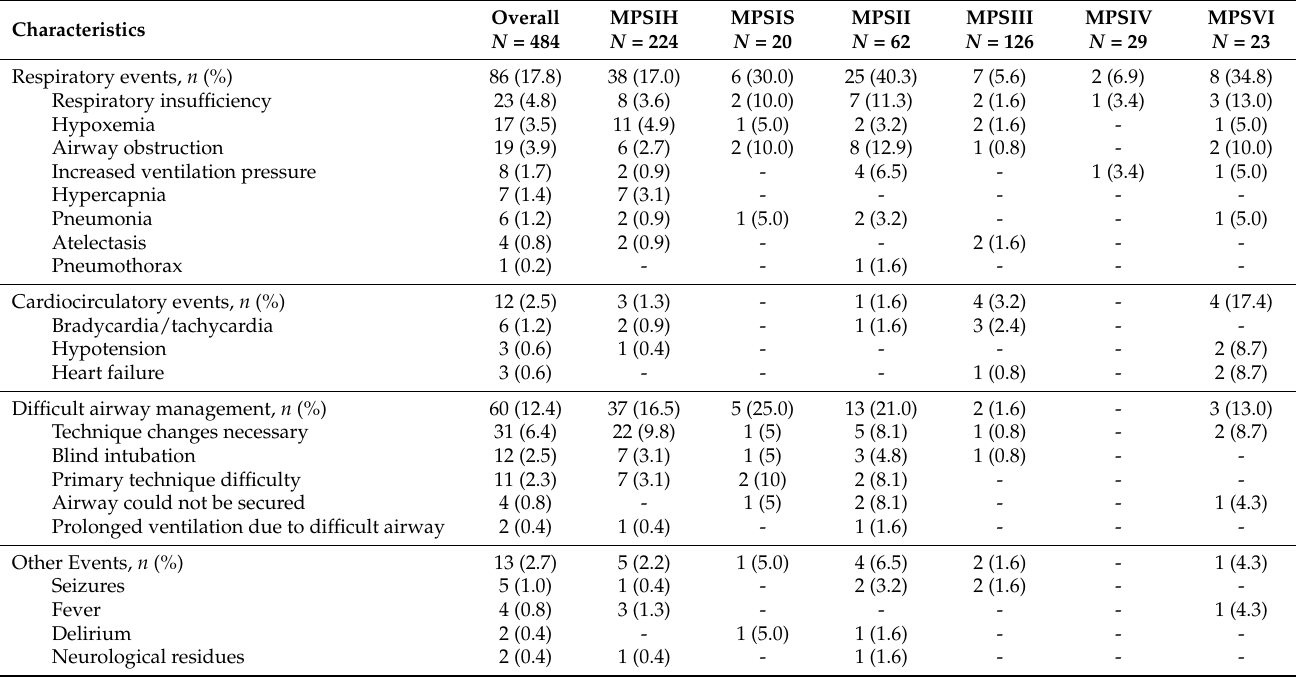
Table 2. Anaesthesia-related complications stratified by MPS disease